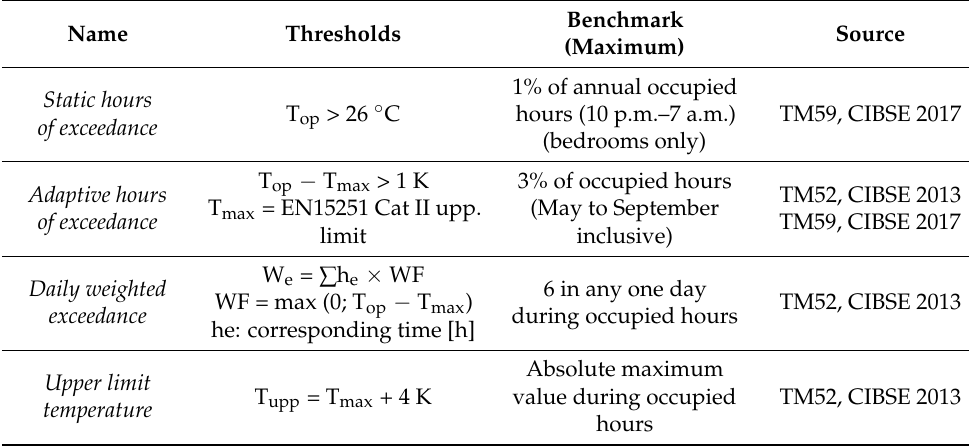
Table 3. Criteria for summer thermal comfort evaluation.